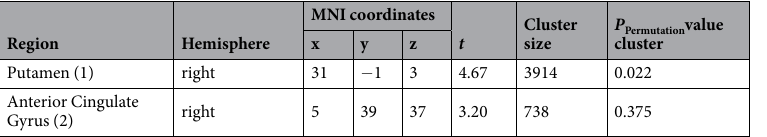
Table 2. Locations of the two biggest clusters. Note. Voxel coordinates are in millimeters after conversion to Montreal Neurological Institute (MNI) stereotactic space. On the voxel level, a high threshold of p < 0.001 was used for the analysis. All results are permutation corrected for multiple comparisons ( p <